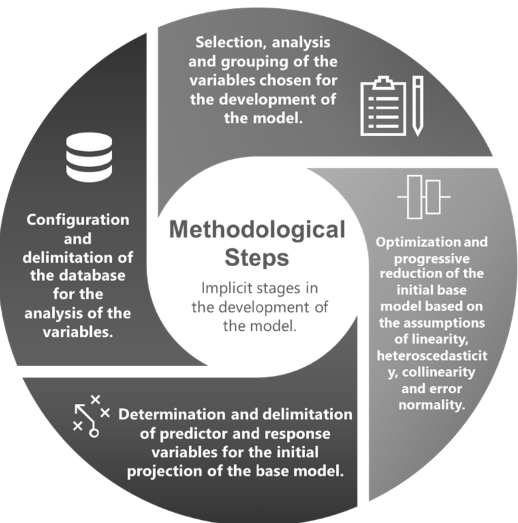
Figure 1. Proposed methodological model presented schematically, own elaboration.